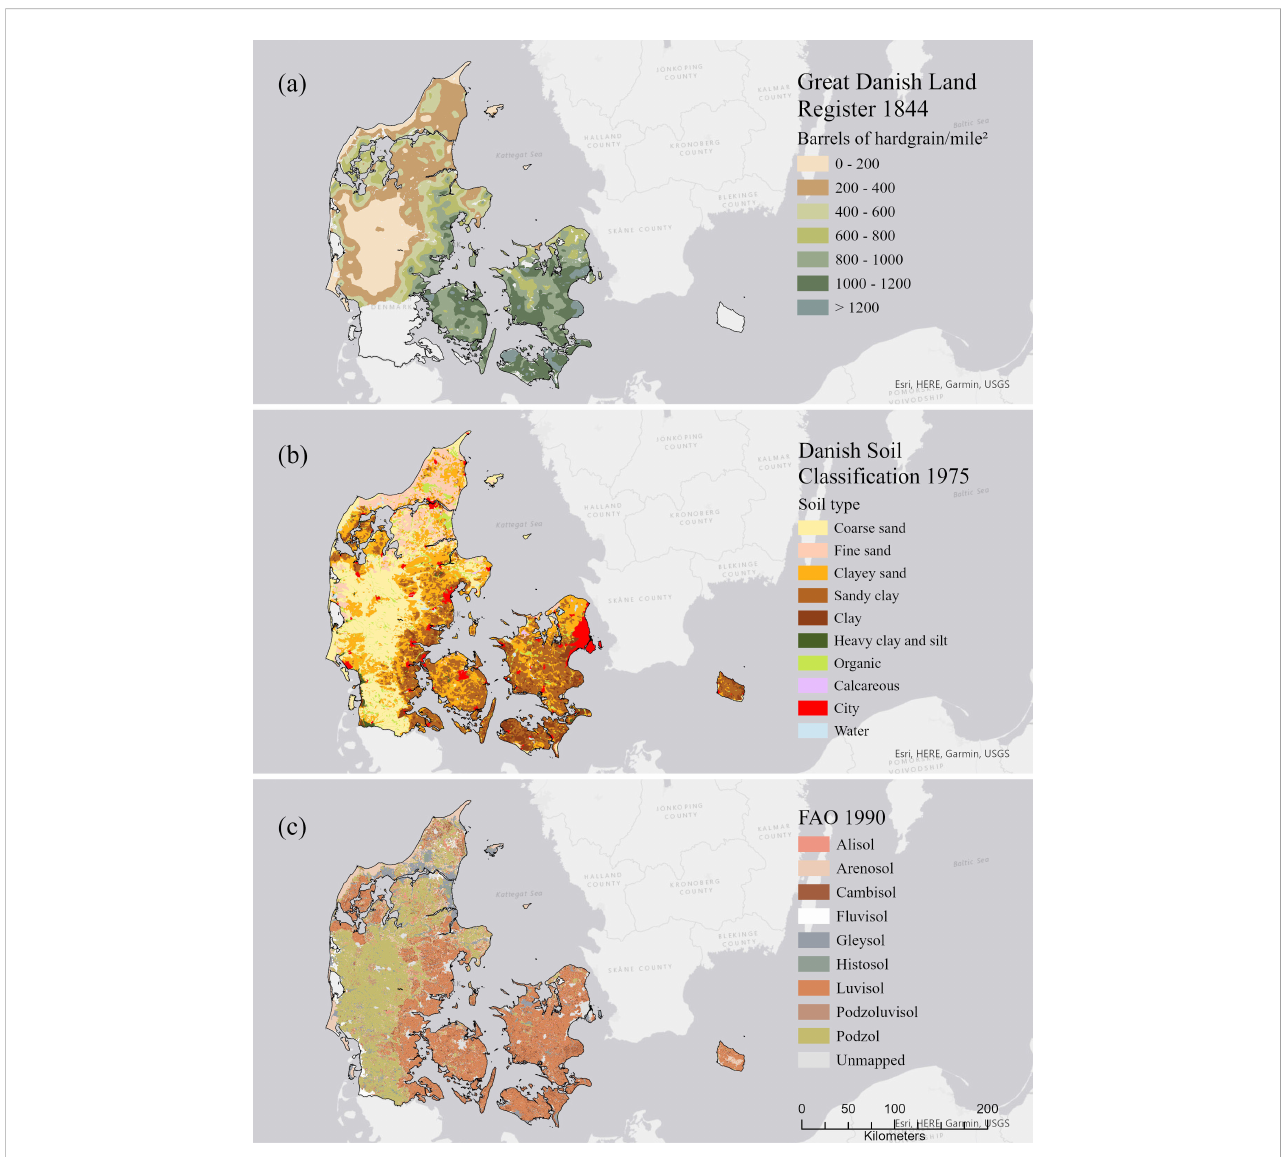
FIGURE 2 The maps represent: (A) the land value used to tax farmers in 1844, (B) soil textural classes developed by the Danish Soil Classi fi cation in 1975, and (C) the soil types according to the FAO legend from